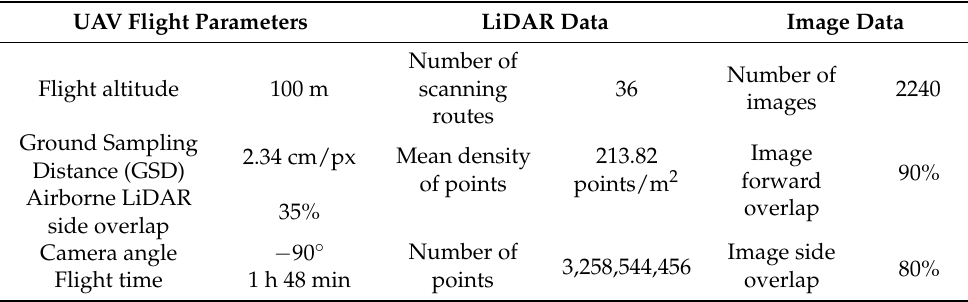
Table 2. The UAV flight parameters and collected data information